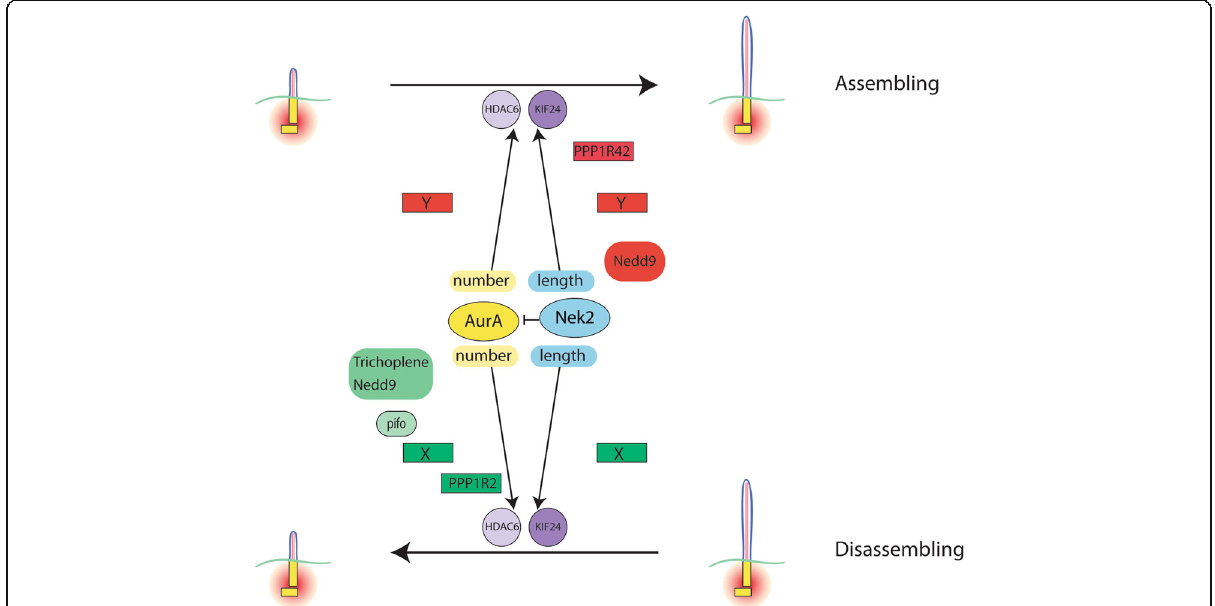
Fig. 10 Positive and negative factors differentially regulate AurA and Nek2. Positive regulators that stimulate depolymerization by AurA and Nek2 when cilia are disassembling are shown in green while factors that counteract depolymerization are shown in red. The downstream targets of the kinases, HDAC6 and KIF24 are shown in shades of purple. The letters X and Y indicated common but unknown negative and positive regulators. Negative regulation of AurA by Nek2 is